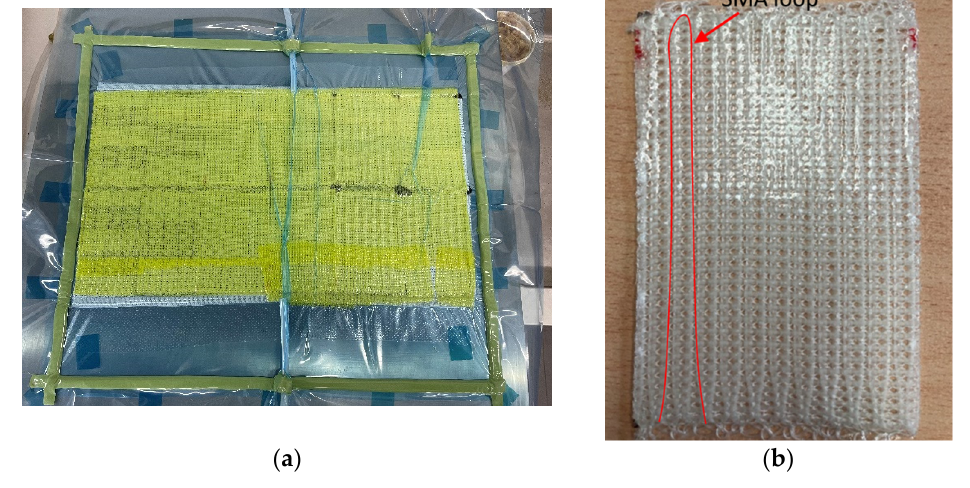
Figure 6 VARI process ( a ) and IFRC specimen ( b